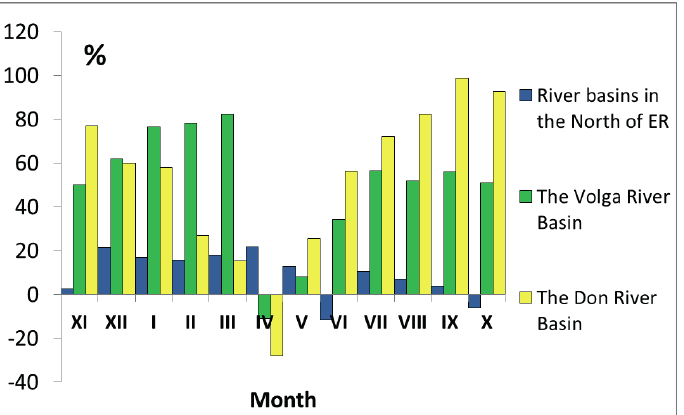
Fig. 5 Changes in the average monthly discharges, which have been averaged over three regions: the Volga Basin, the Don Basin and the river basins in the northern ER for the period from 1975 to 2010 relative to the period from 1945 to 1974, in